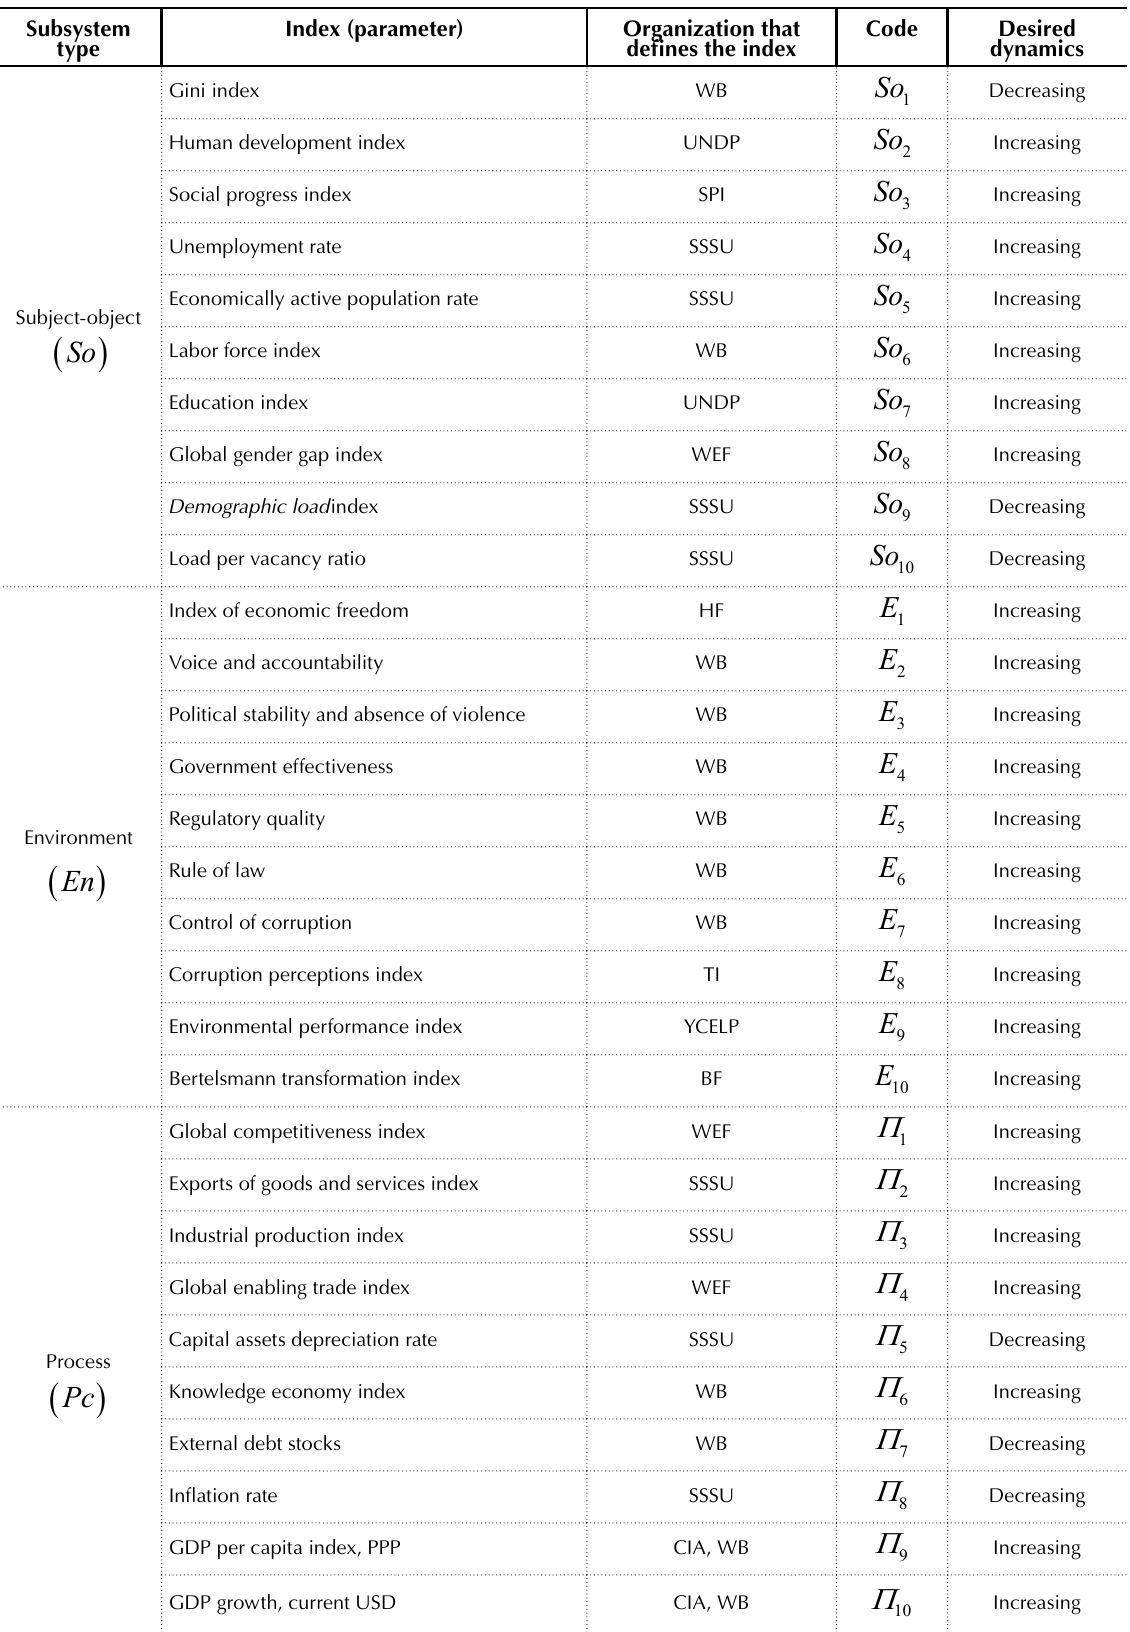
Table 2. Characteristics of functioning parameters of the subsystems of socio-economic system of Ukraine Subsystem